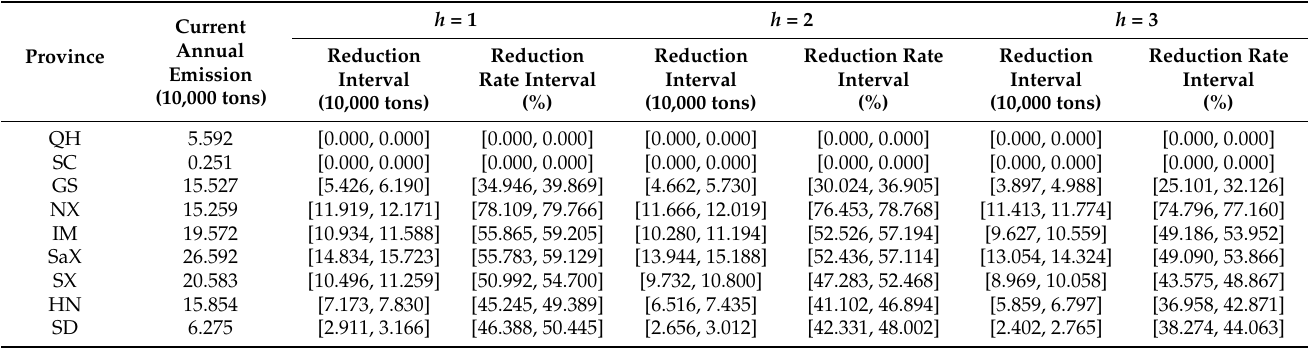
Table 5. The reduction plan of COD in each province under different